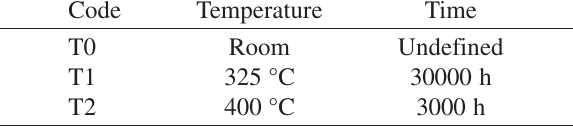
Table 2. Aging heat